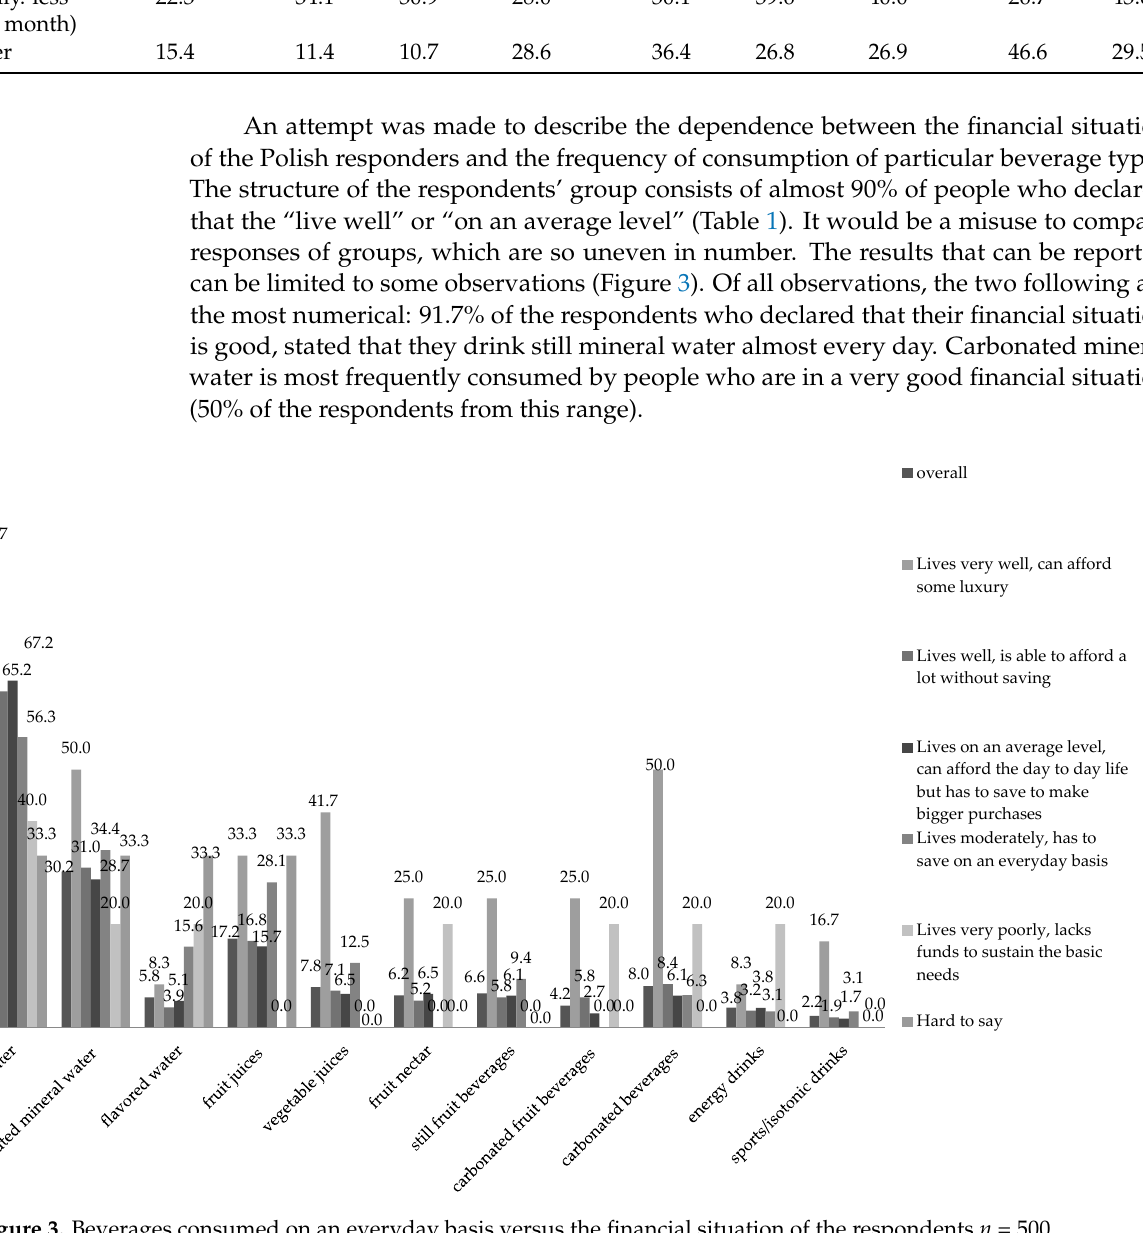
Figure 3. Beverages consumed on an everyday basis versus the financial situation of the respondents n = 500. Table 3. Correlation of Selected Drinks consumed by Polish Adults, using Spearman’s rank correlation coefficient.